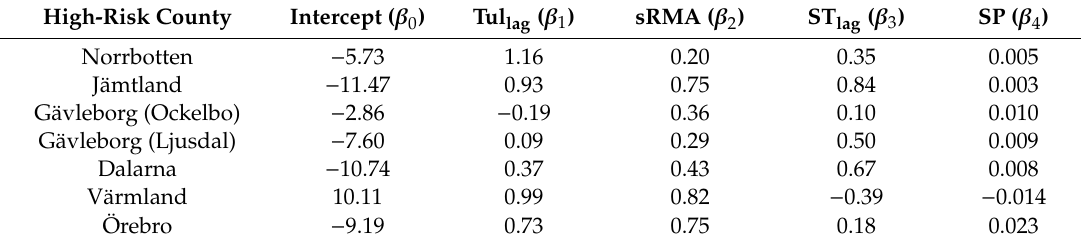
Table 1. Tularemia model coe ffi cients assigned to the six Swedish study